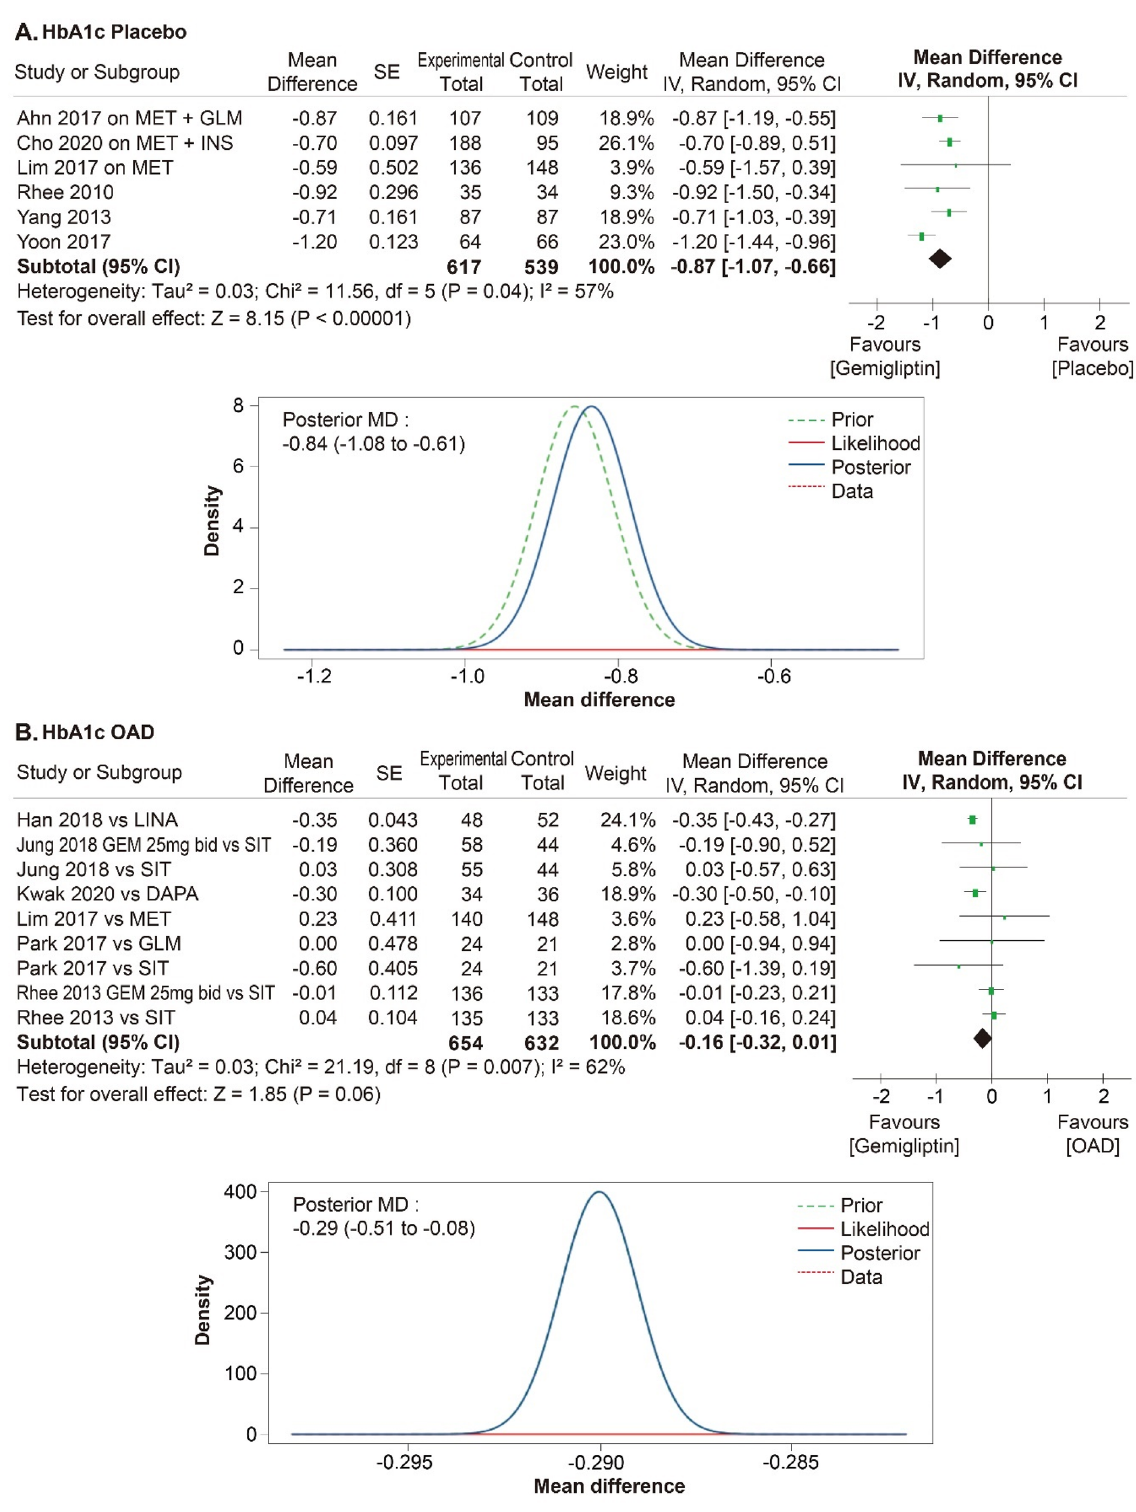
Figure 4. Forest plot of RCTs for the effect of gemigliptin on